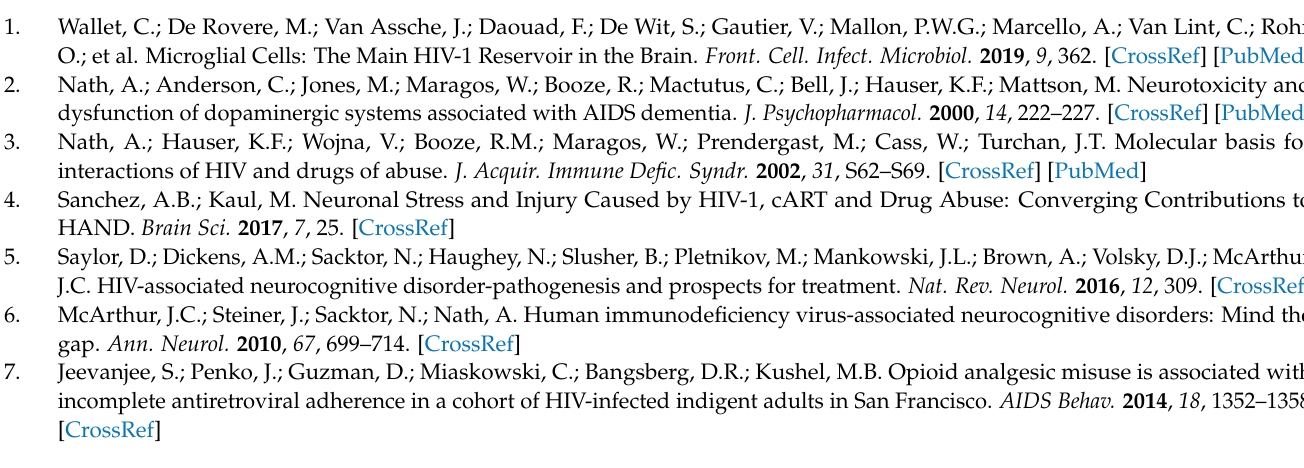
Figure S1: Fold changes of tat mRNA expression using Quantitative Real-Time Polymerase Chain Reaction (qRT-PCR), Figure S2: Motor behavioral measures acquired in open field, Table S1: Primers used for qRT-PCR, Table S2: Summary of findings for primary dependent